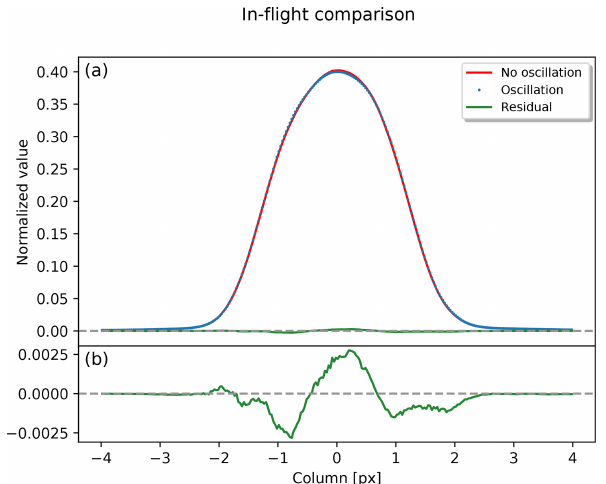
Figure 18. Comparison between the ISRF measurements taken with and without an oscillating diffuser. In-flight measurements during nominal operations are carried out without an oscillating diffuser. Panel (a) shows the normalized pixel response in-flight (red) and on the ground (blue). The residuals are plotted in green. Panel (b) shows a zoomed in section of the residuals.